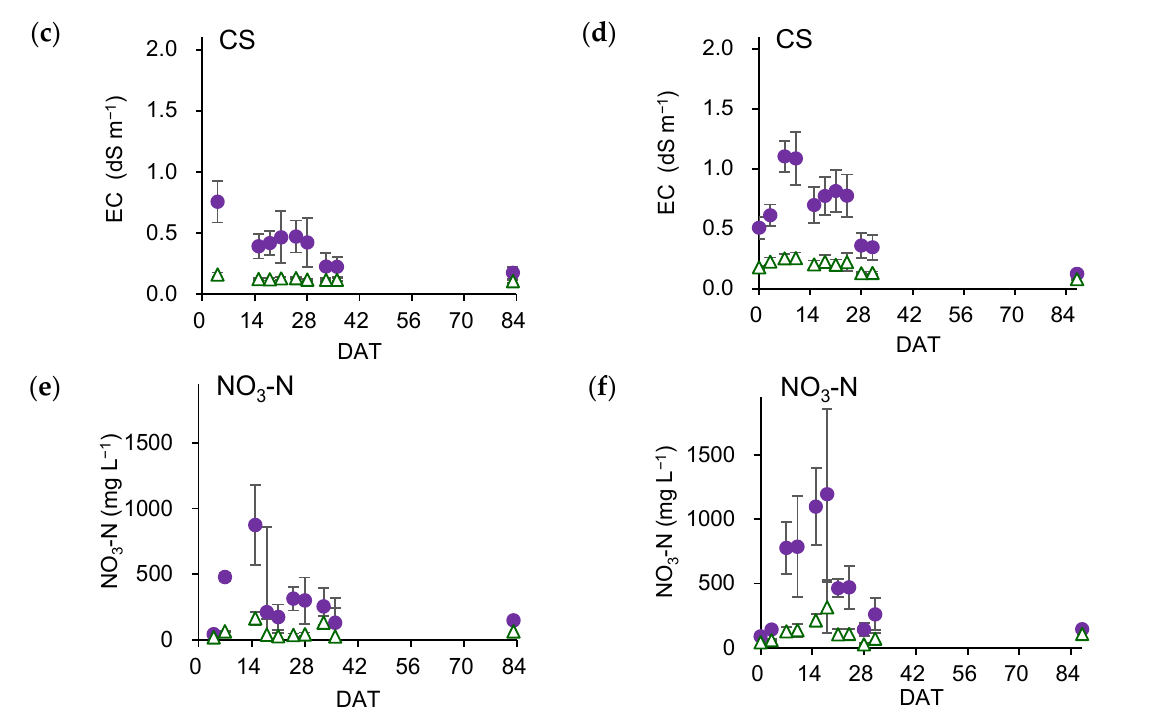
Figure 4. Electrical conductivity (EC) measured by the HP ( a , b ), EC measured by the CS ( c , d ) and nitrate concentration measured by the soil nitrate meter ( e , f ) at multiple points (Trial 1 and 2). Values represent the mean obtained from 25 (fertilized plot) or 6–7 (non-fertilized plot) replicates. Bars represent standard deviation (SD). EC measured by the CS on 7 DAT in Trial 1 is missing.